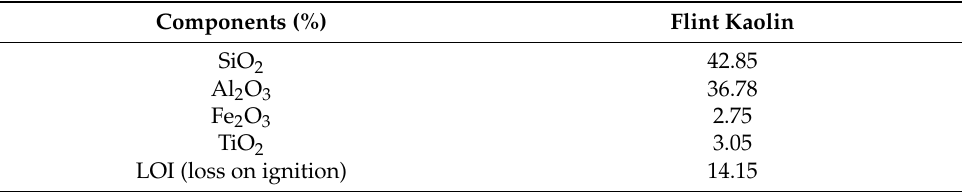
Table 1. Chemical composition of the flint kaolin.